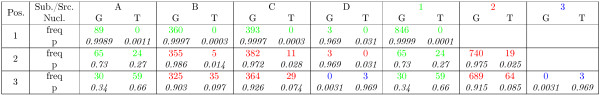
Examples of the calculation of the emission probabilities. Simplified example of position- and subtype-wise nucleotide frequencies of HIV and the emission probabilities derived from them using the presented information sharing protocol. For three sites the subtype-wise nucleotide frequencies for the four subtypes A-D are given on the left side of the table. Below them, the emission probabilities estimated based only on the frequencies of the respective subtype are shown, using pseudocounts α→=(0.1,0.1). The colors indicate which subtypes should be jointly modeled in order to get the most likely source combination. The nucleotide frequencies of the sources (i.e. the aggregated frequencies of the subtypes belonging to it) as well as the emission probabilities estimated based on these frequencies are given on the right side of the table (using the same α→). For the sake of simplicity, we assume only the nucleotides G and T occur. Apart from this simplification and the restriction to four subtypes, this example is taken from actual HIV-1 sequences.